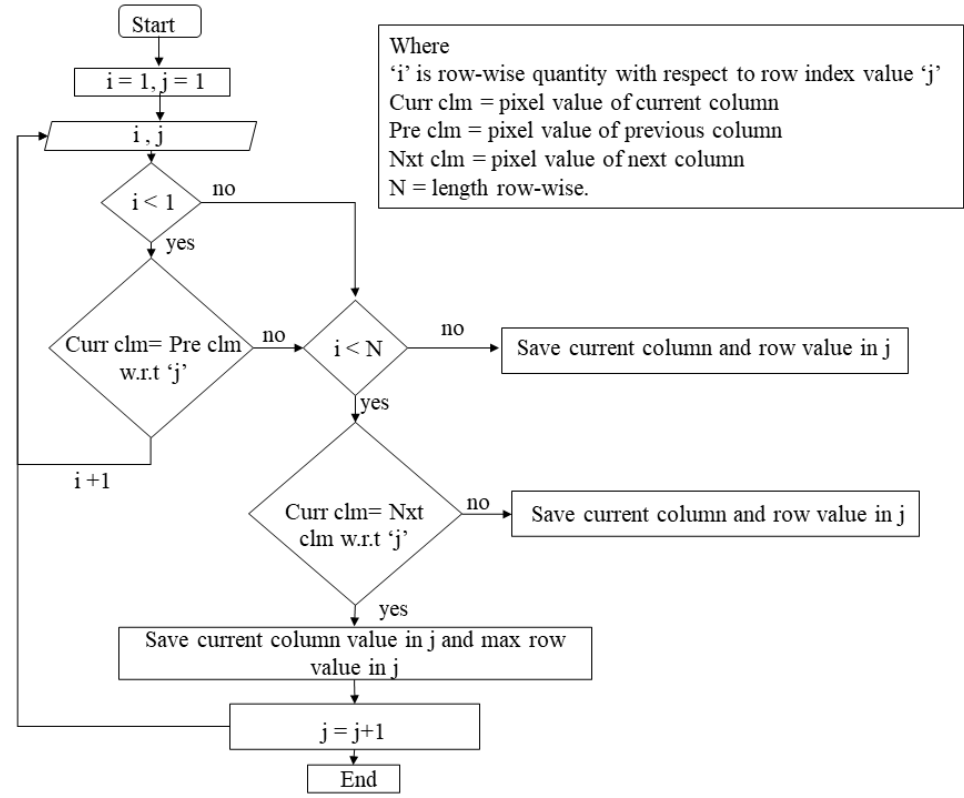
Figure 6. Flow chart for pixel indexing.